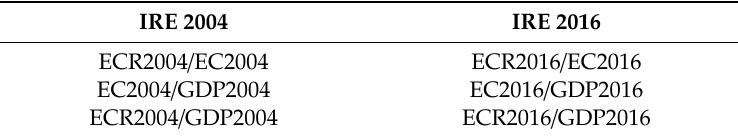
Table 1. Indicators of renewable energy.